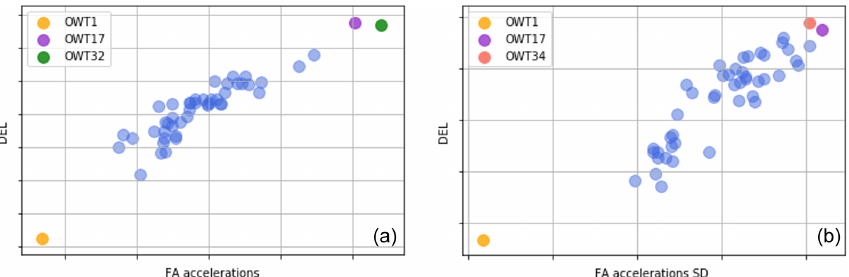
Figure 18. (a) DEL (for scenario D) vs. mean fore–aft low-quality absolute accelerations for every turbine of the farm. OWT 1 is parked, and OWT 17 and OWT 32 are outliers. (b) DEL (for scenario F) vs. the standard deviation of fore–aft accelerations for every turbine of the farm. OWT 1 is parked, and OWT 17 and OWT 34 are